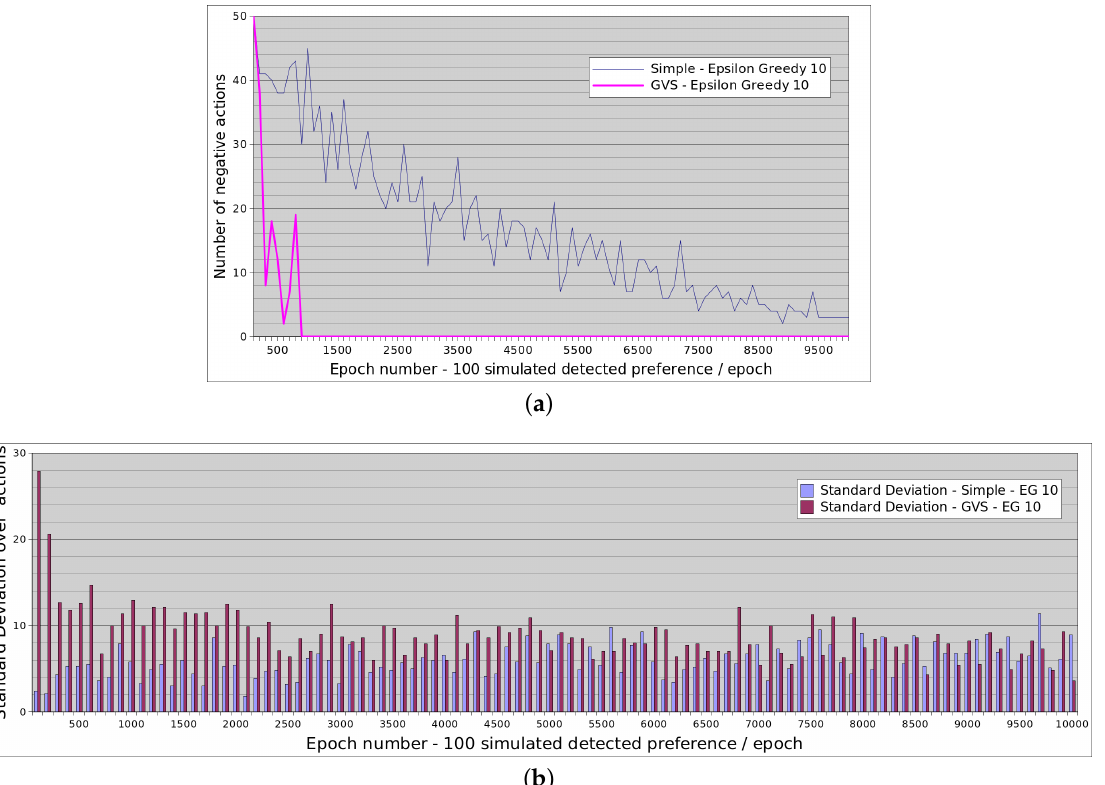
Figure 5. Simulated results comparing the GVS algorithm with a simple method using an epsilon greedy mechanism with (cid:101) = 10 in the action selection process. ( a ) the number of negative actions in each epoch; ( b ) the standard deviation between the number of times each action was used during an